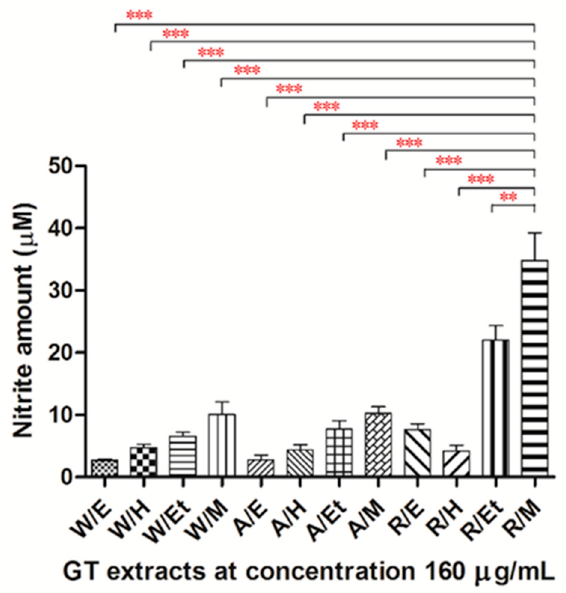
Figure 2. One-way ANOVA analysis and post-hoc analysis for NO production on various extracts. HUVECs were treated with each extract for 24 h. NO production was determined as the formation of nitrite. Data were obtained from five replicate experiments , and are expressed as mean ± standard deviation. W, whole plant; A, aerial; R, root; E, EA extract; H, hexane extract; Et, ethanol extract; M, methanol extract. A significant difference was indicated as ** p < 0.01 or *** p < 0.001.